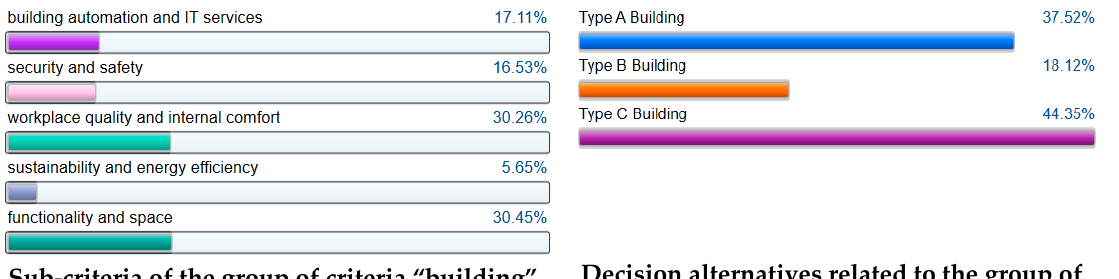
Figure 3. The original evaluations by experts (%) that provide a relevance ranking of sub-criteria of the group of criteria “building” with regard to the choice of adequate office space for BPO tenants.